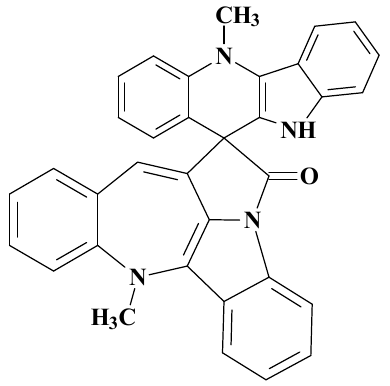
Figure 6. Spiro nonacyclic alkaloid cryptospirolepine 1.